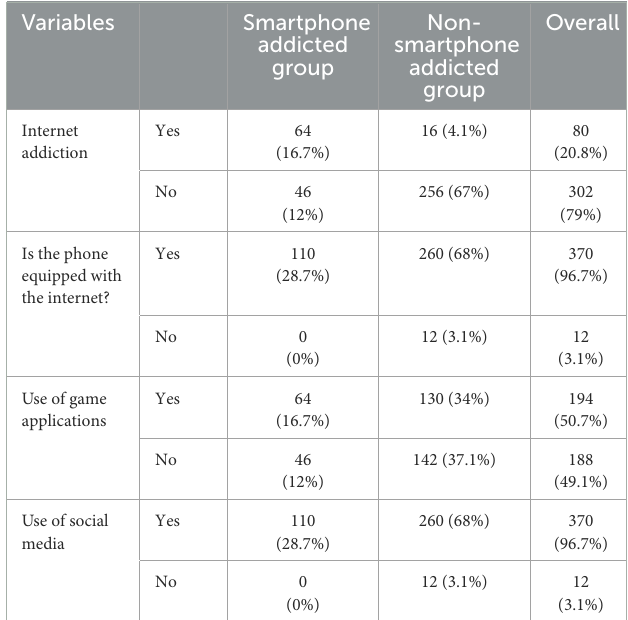
TABLE 2 Comparison of simultaneous internet addiction, the phone being equipped with internet, using game applications, and using social media in two groups of smartphone addiction and non-addiction in Tehran’s university